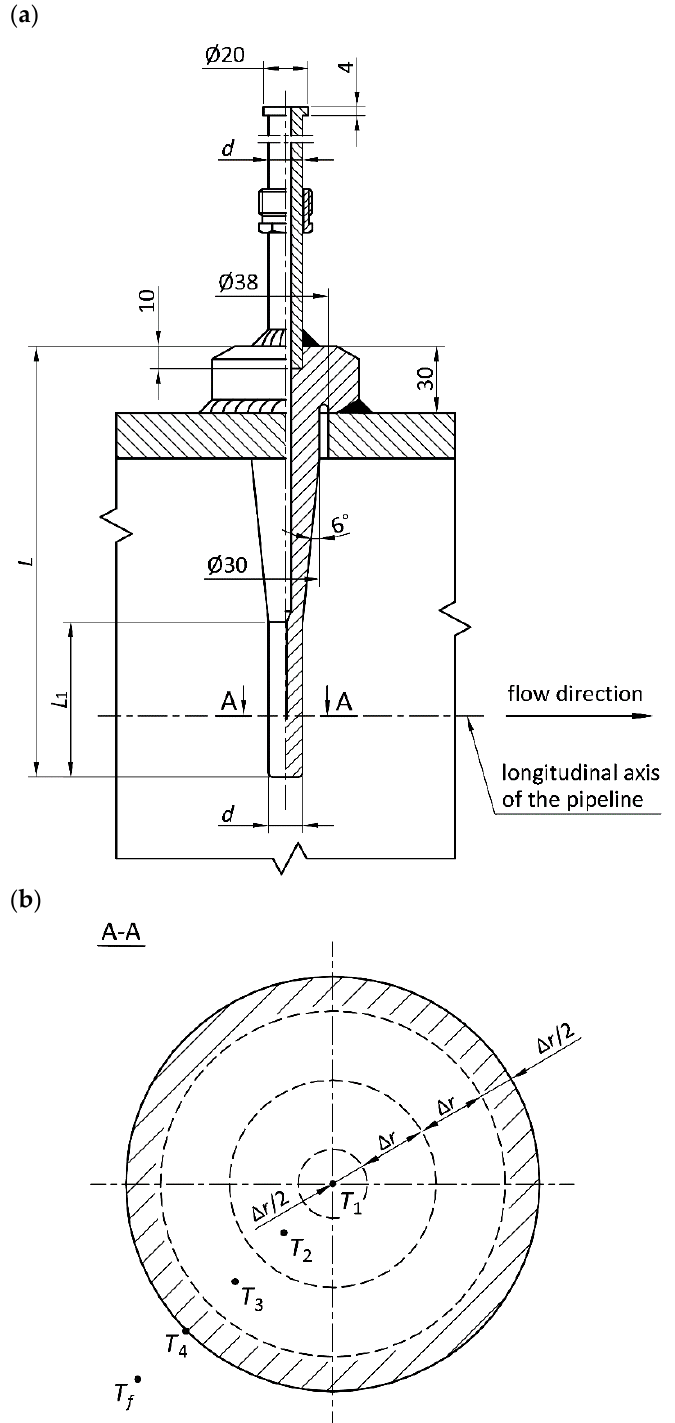
Figure 1. New thermometer for measuring the temperature of the fluid at high pressure: ( a ) general view—longitudinal section, ( b ) dividing the cylindrical element into four control volumes.